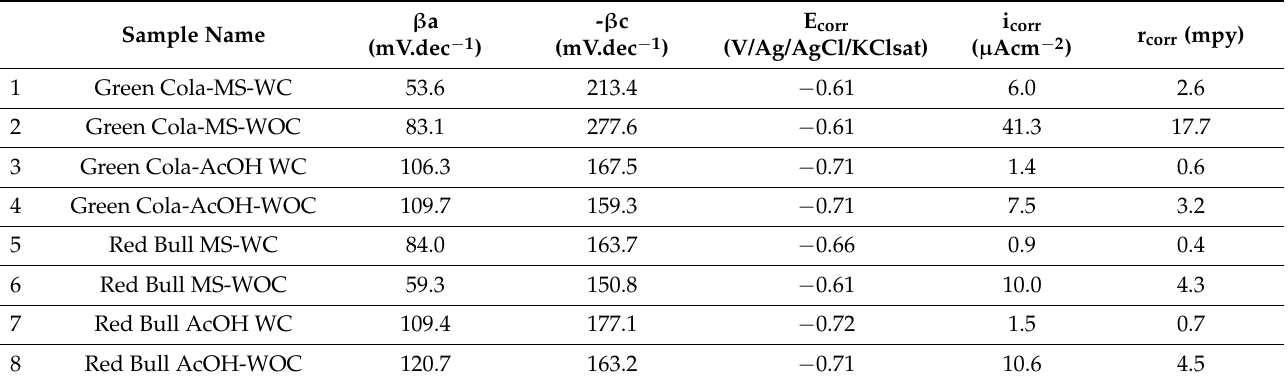
Figure 6. Potentiodynamic polarization curves of ( a ) Green Cola and ( b ) Red Bull samples in main and acetic acid [0.1 M] solutions with and without an internal organic coating; Ewe: working electrode potential. Table 3. Polarization results summary: anodic and cathodic Tafel slope ( β a and β c), corrosion potential (Ecoor), corrosion current density (icorr), and corrosion rate (r corr) for both Green Cola and Red Bull at room temperature.